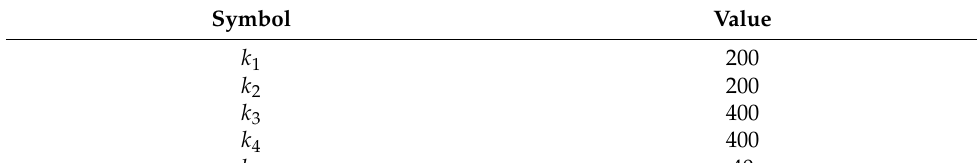
Table 6. The second set of backstepping control parameters.